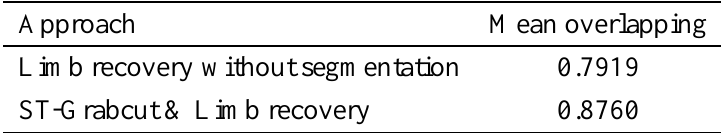
Table 4. Overlapping of body limbs based on ground truth